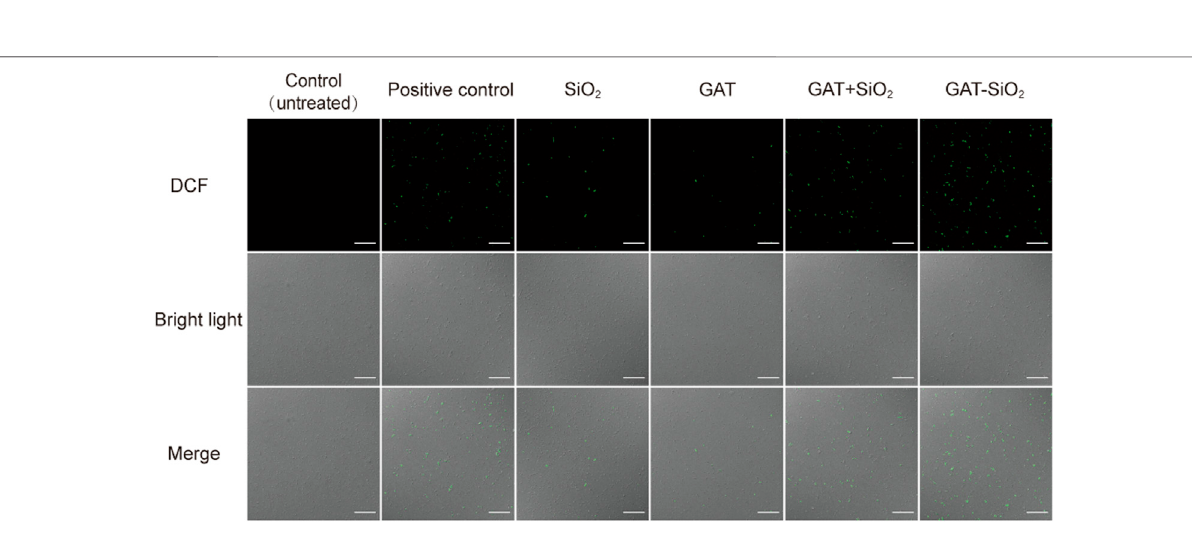
Frontiers in Chemistry |